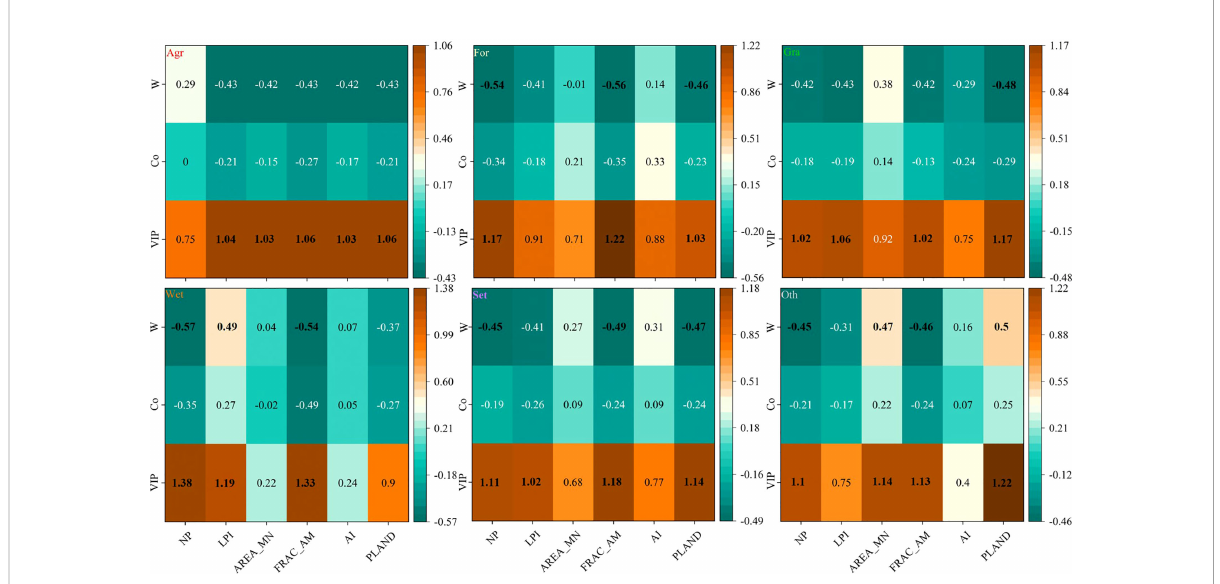
FIGURE 9 PLSR variable importance and weights of the fi rst component and regression coef fi cient for HQ model. Co, regression coef fi cients; VIP, variable importance in projection; W, weight; NP, number of patches; LPI, largest patch index; AREA_MN, mean patch area; FRAC_AM, area-weighted mean fractal dimension index; AI, aggregation index; PLAND, percentage of landscape; Agr, agricultural land; For, forestland; Gra, grassland; Wet, wetland; Set,settlement. Whereas Oth refers to other types of LULC which include water, bare land, snow and ice. Bold face, values indicate (w 2 > 0.2) the importance of predictor